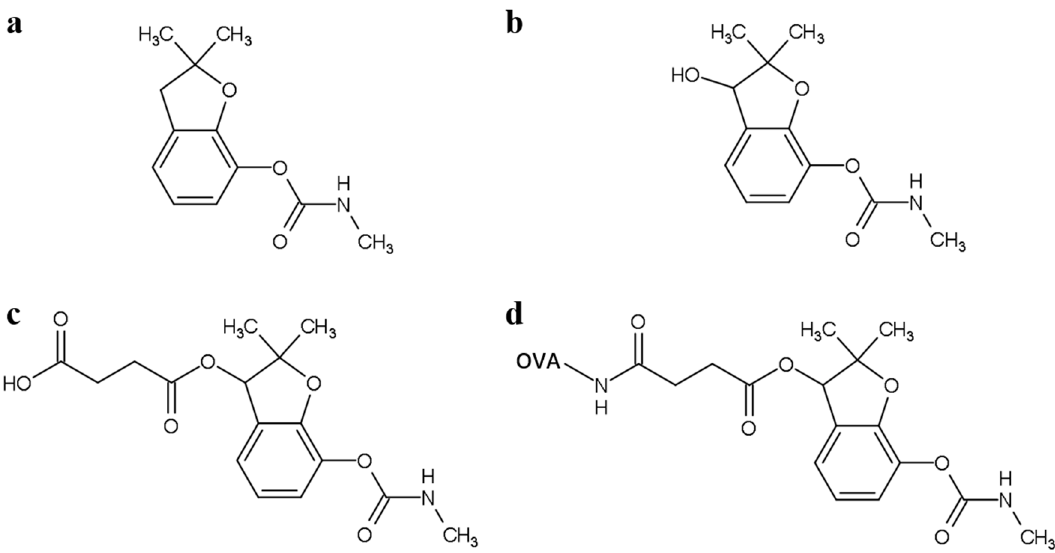
Figure 1. Chemical structures of the related compounds: ( a ) carbofuran, ( b ) 3-hydroxy-carbofuran, ( c ) 3-succinyl–CBF and ( d ) 3-succinyl-CBF-OVA. CBF, carbofuran; OVA, ovalbumin.